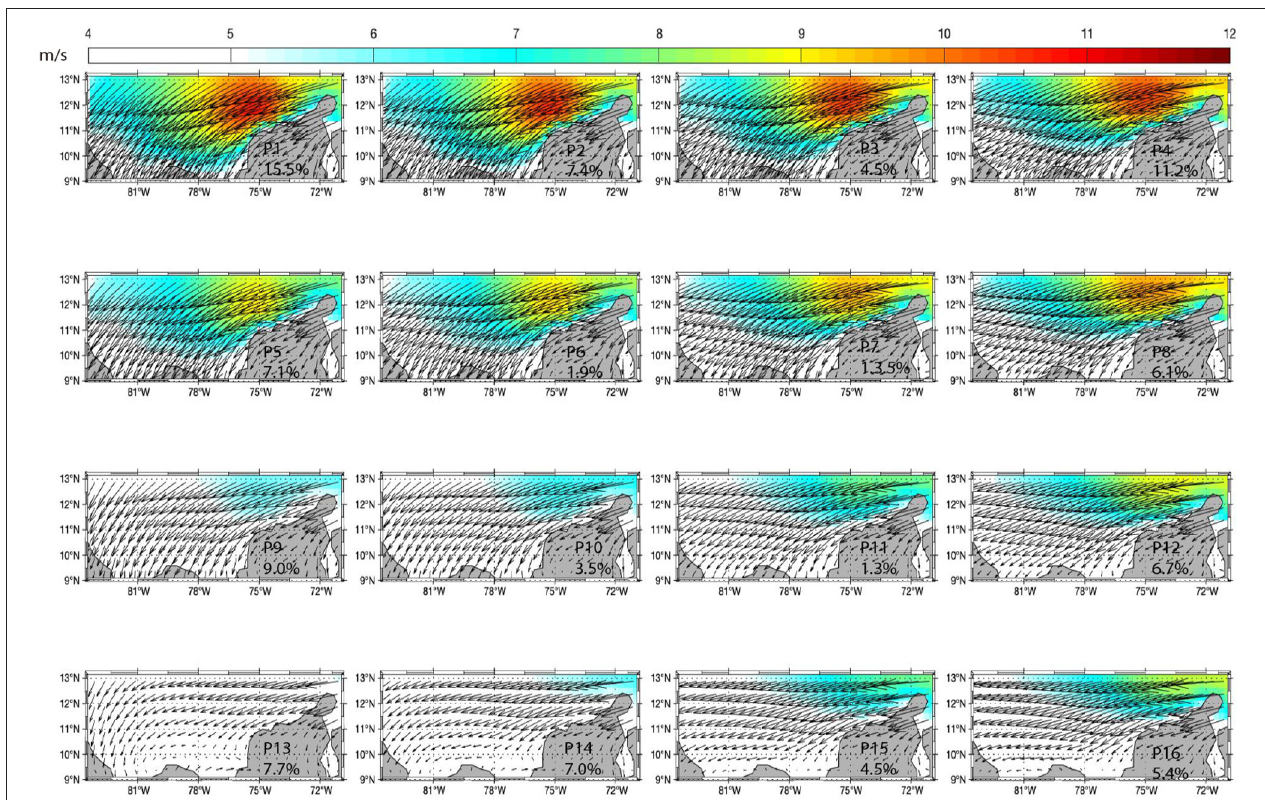
FIGURE 9 | Spatial patterns of surface winds given by a 4 × 4 SOM analysis in the Caribbean Sea computed from weekly surface winds over the time period 2007–2012. The colorbar indicates the wind speed in m · s − 1